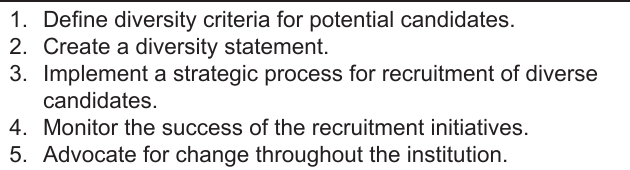
Table 3. Responsibilities of recruitment committees.